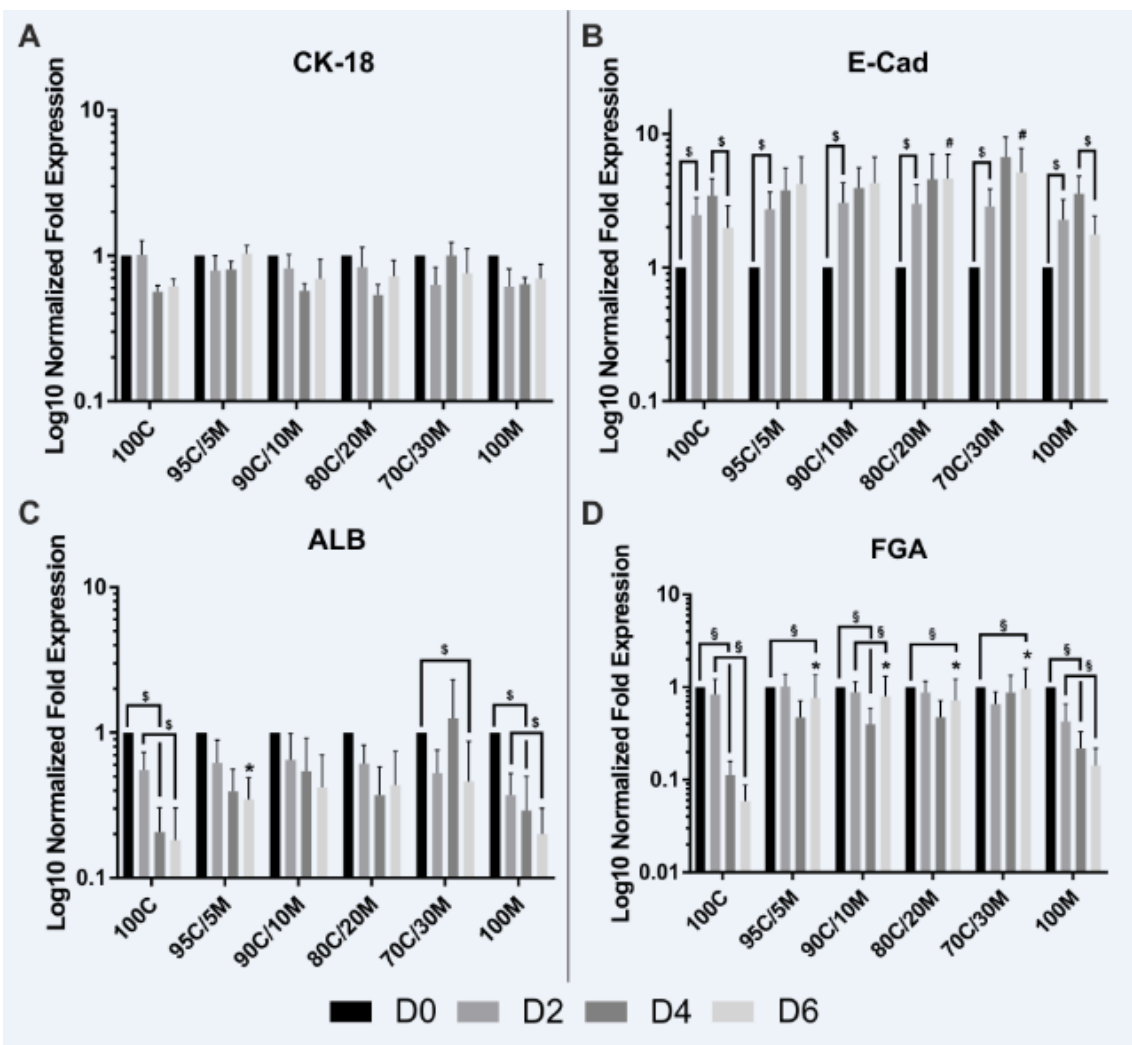
Figure 2: Gene expression of differentiation markers in primary human hepatocytes (PHHs) in mono- layer cultures (MCs) on different extracellular matrices (ECMs). PHHs were cultured for up to 6 days on pure collagen type I (100C), on ECMs based on collagen type I (C), supplemented with ascending per- centages of Matrigel (M): 95C/5M, 90C/10M, 80C/20M, 70C/30M or on pure Matrigel (100M). Messen- ger RNA levels of ( A ) CK-18 (keratin 18), ( B ) E-Cad (E-cadherin), ( C ) ALB (albumin) and ( D ) FGA (fibrinogen alpha chain) were determined by RT-qPCR. Fold gene expressions were normalized to day 0 of each cultivation type. Data are shown as the mean of normalized fold gene expressions + SEM on a log10-scale, n = 3, two-way ANOVA and Bonferroni correction for multiple testing, statistics were performed on ΔCT values, statistical significance was assumed at p ≤ 0.0332. Significant differences between PHHs cultured on one of the various matrices in comparison to PHHs cultured on 100C of the same day are marked with *. Significant differences between PHHs cultured on one of the various ma- trices in comparison to PHHs cultured on 100M of the same day are marked with #. Significant differ- ences observed at different time points of PHHs cultured on the same ECM are marked with §. Selected comparisons are shown; for details on the statistical evaluation, see Supplementary Table 1B, supple- mentary